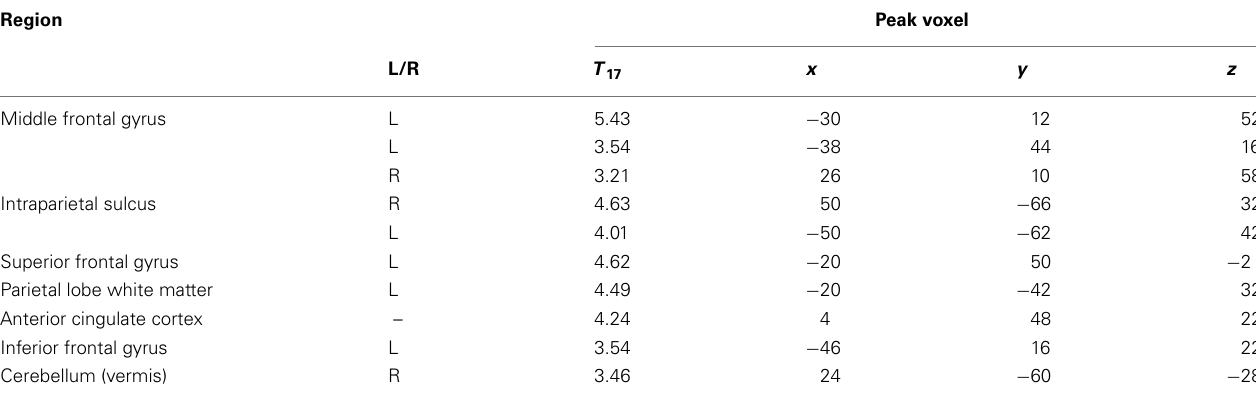
(B) These regions of the IPS and ACC overlapped with those identified as related to decision-making across all subjects.Yellow areas are those that were significant for the PPI analysis and which were also found to correlate with ratio (conjunction at p < 0.05, corrected, for both tests). See Table 4 .